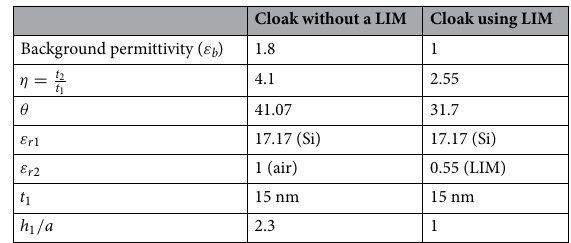
Table 1. Design parameters of two cloaks, with and without low index layers, are compared with each other in this table.